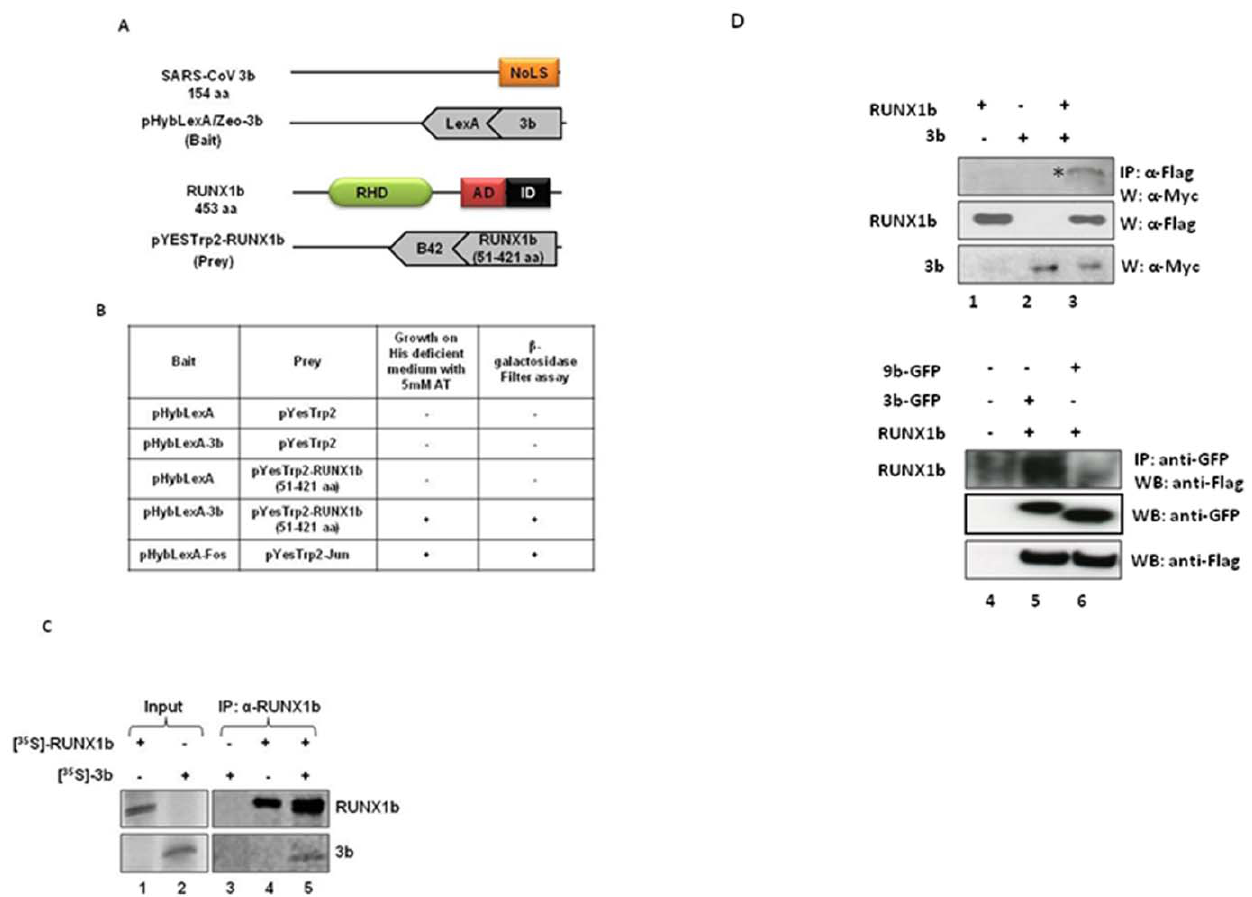
Figure 1. SARS-CoV 3b interacts with RUNX1b. A. A schematic representation of full-length 3b, pHybLexA/Zeo-3b bait plasmid, full-length RUNX1b and pYesTrp2-RUNX1b (51–421 aa) prey plasmid. The 3b protein has a nucleolar localization signal (NoLS) at the C-terminus. The RUNX1b protein has a runt homology domain (RHD, 50–177 aa), an activation domain (AD, 291–171 aa), and an inhibitory domain (ID, 346–411 aa). B. The 3b- RUNX1b interaction was assessed on a selective growth media (supplemented with 3-AT) and by filter lift b -galactosidase activity assay in a yeast two-hybrid experiment. pHybLexA/Zeo, pYesTrp2, pHybLexA/Zeo-3b, pYesTrp2-RUNX1b, pHybLexA/Zeo-Fos and pYesTrp2-Jun constructs were co- transformed in L40 in combinations tabulated above. pHybLexA/Zeo-Fos and pYesTrp2-Jun were used as positive control. C, D. In vitro analysis of 3b and RUNX1b interaction. C. In vitro translated S 35- labelled 3b and RUNX1b lysates (input) were subjected to co-immunoprecipitation alone or together, using a –RUNX1 antibody. D. Total cell lysates of Huh7 cells expressing indicated proteins were immunoprecipitated with a -Flag antibody and western blotted with a -myc antibody to probe 3b protein (panel 1). Lysates were probed for the expression of RUNX1b and 3b with a -Flag and a - myc antibodies,